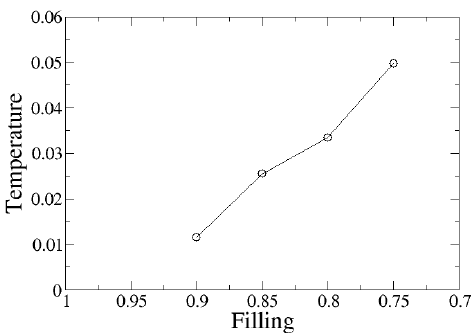
Figure 3. The quasi-particle weight at the Fermi surface along the < 111 > direction as a function of filling, N . There is a clear separatrix between the behavior in highly doped systems and those near half-filling. The division occurs at about N = 0.95. The dotted lines show the crossover form fit (see Equation (9)).